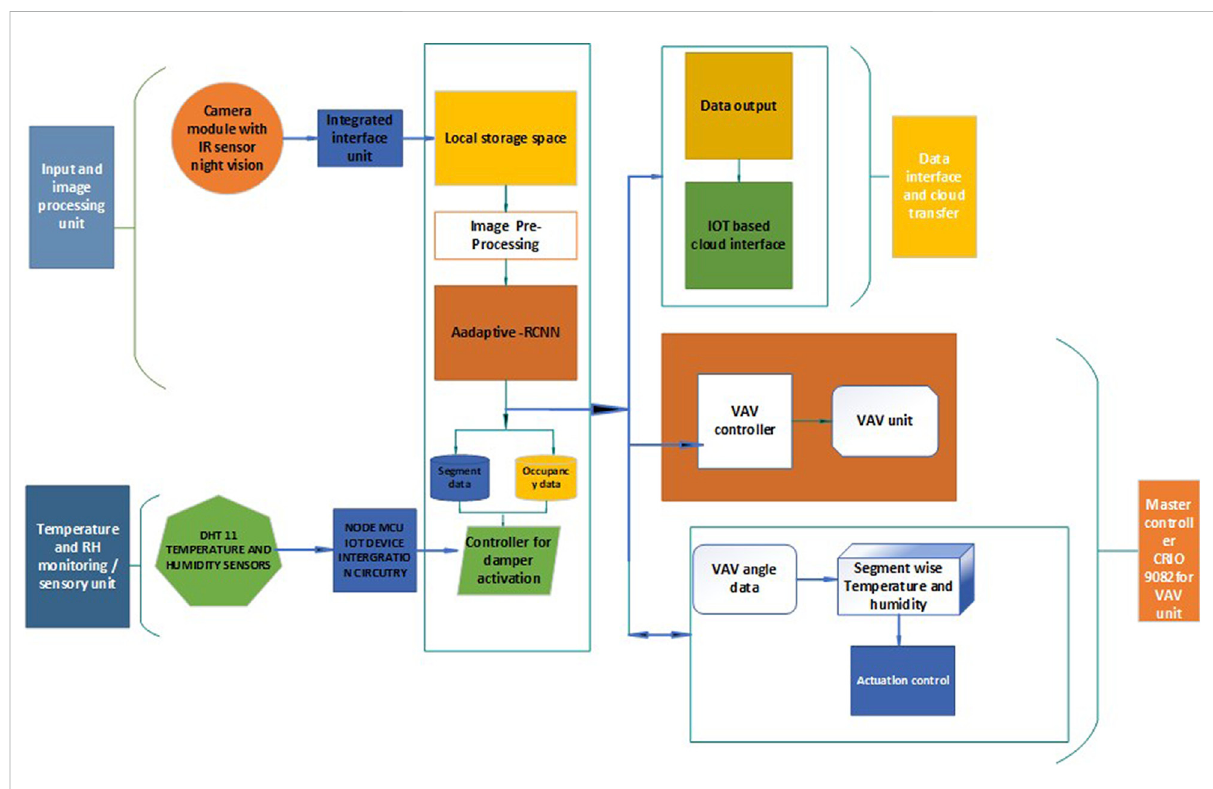
FIGURE 1 Schematic framework of the proposed HVAC control